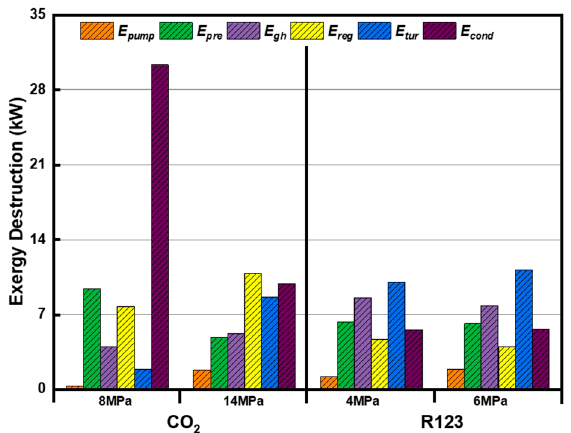
ff erent turbine inlet